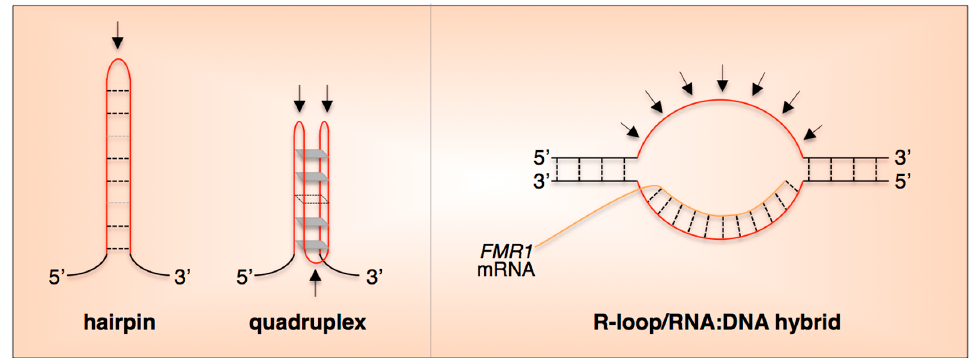
Figure 2. Generic representation of some of the unusual DNA structures described for the FX repeats. The arrows indicate single ‐ stranded regions. Both DNA strands can form hairpins containing a mixture of Watson ‐ Crick G•C base pairs (black dashed lines) and either G•G or C•C mispairs in the case of the CGG ‐ strand and CCG ‐ strand, respectively (gray dashed lines) [30 ‐ 33,39]. Hairpin formation on one strand may facilitate hairpin formation on the other. This could result in the formation of Slipped DNA (S ‐ DNA) [40] if the hairpins are offset. Quadruplexes may involve G4 ‐ tetrads and/or GCGC ‐ tetrads (gray parallelograms) with C•C mismatches (dashed lines) [29,31,41 ‐ 43]. The repeat tract can also form an R ‐ loop containing an RNA:DNA hybrid formed between CGG ‐ repeats in the transcript and the CCG ‐ repeats in the DNA template [35,36,44]. In principle this hybrid could form in cis (perhaps co ‐ transcriptionally) or in trans.